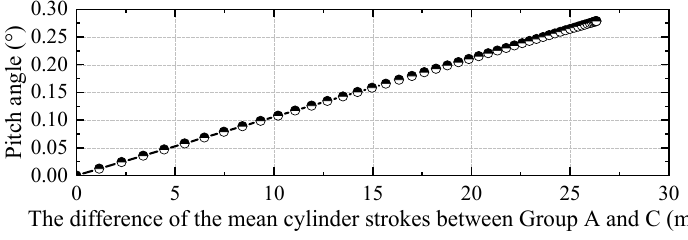
The difference of the mean cylinder strokes between Group B and D (mm) Figure 9. The attitude angles variation with the difference of mean cylinder strokes. The cylinder of No.4 (top-left), No.11 (down-left), No.18 (down-right) and No.25 (up-right) were picked out, and their velocity variations with time are plotted in Figure 10. It can be seen that velocities presented a decreasing trend with time and decreased faster and faster. The velocity of cylinder No.4 was maximal, and the velocity of cylinder No.18 was minimal. The velocities of cylinder No.11 and No.25 were basically equal. This is because the shield machine deflected in the direction of top-left. opposite direction, it was the largest.